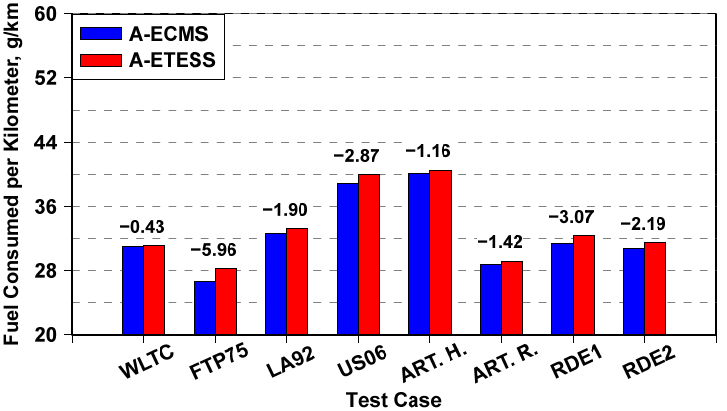
Figure 16. Comparison between A-ECMS and A-ETESS of kilometric consumed fuel and percent difference for the test cases of Table 2.